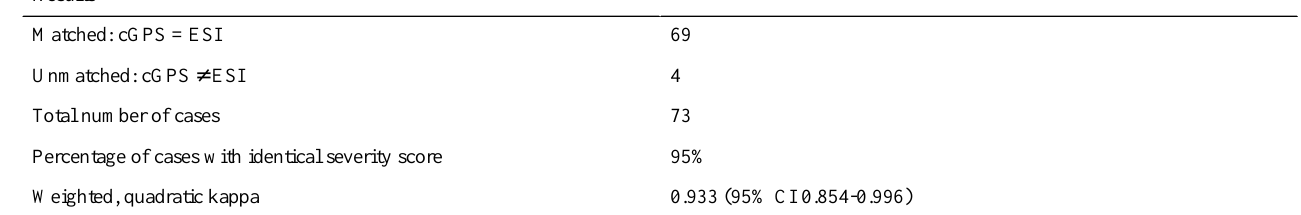
Table 3. Results of the analysis using all case vignettes